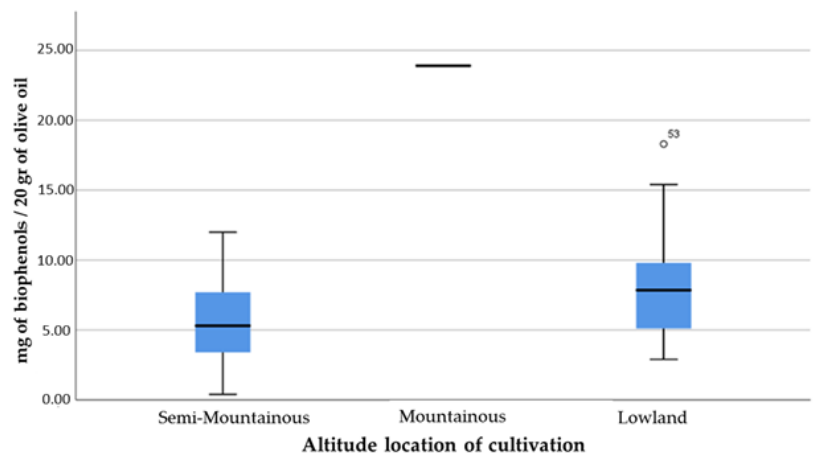
Figure 5. Comparison of biophenol concentrations by the altitude location of cultivation.